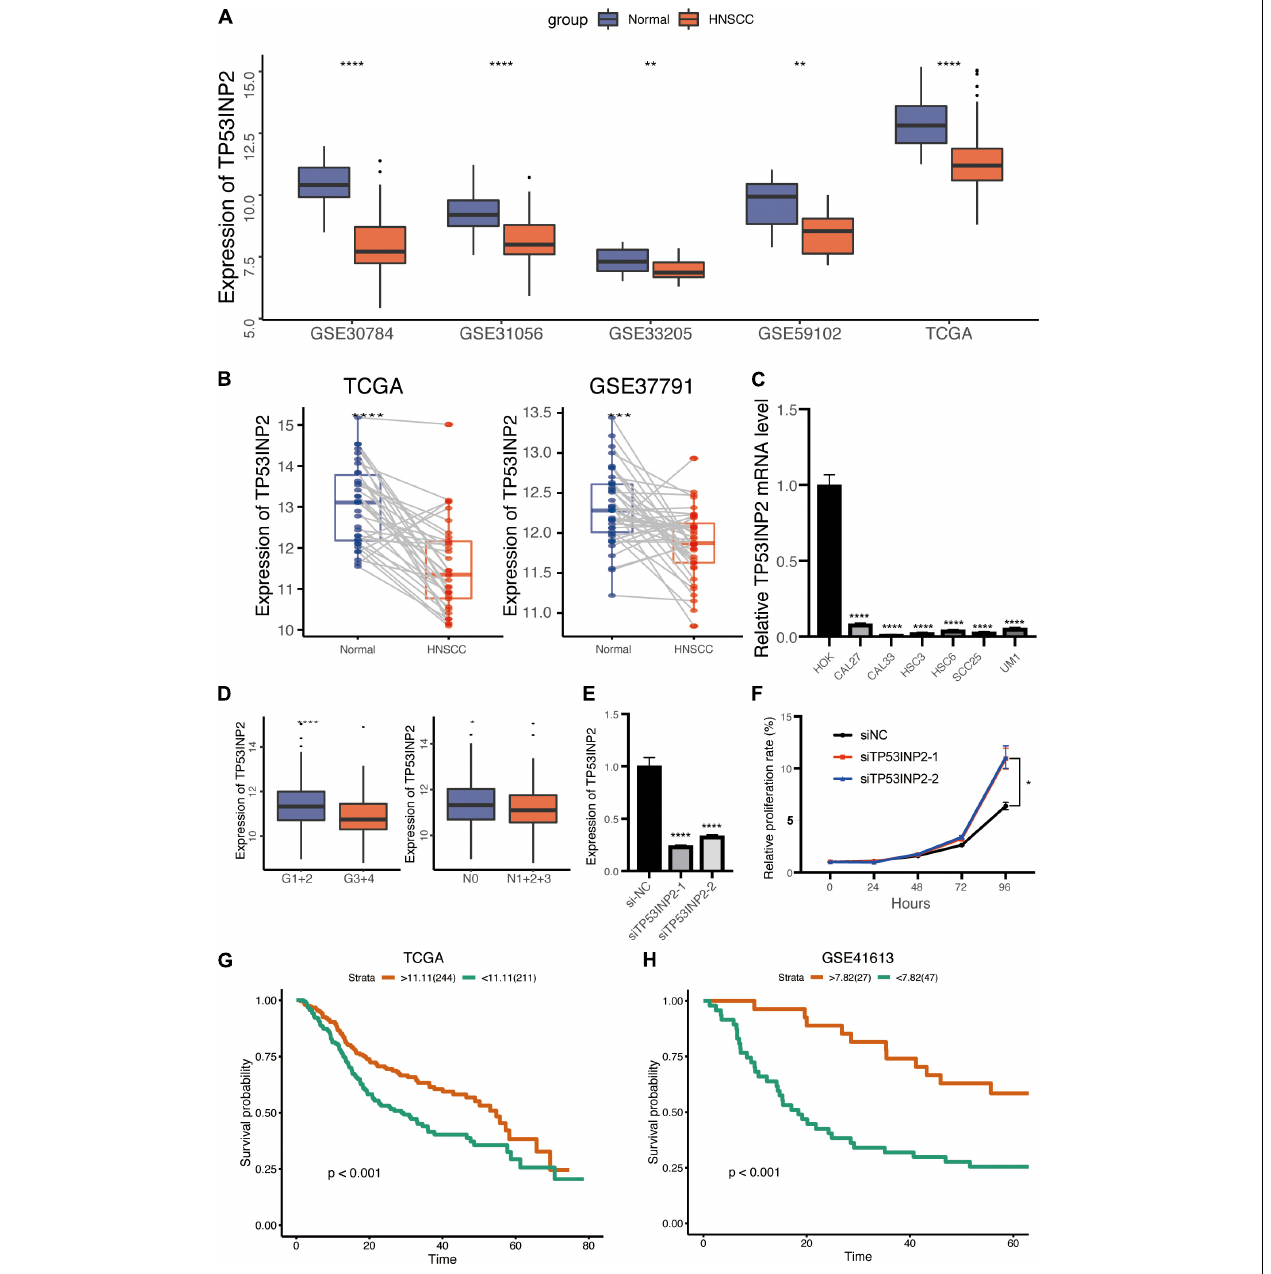
FIGURE 1 | Low expression of TP53INP2 predicts prognosis in HNSCC. (A) Box plot of TP53INP2 expression between HNSCC and normal controls in multiple datasets. (B) Box plot of TP53INP2 expression between HNSCC and paired normal controls. (C) The relative expression of TP53INP2 expression between HNSCC cell lines and normal controls. (D) Box plot of TP53INP2 in grade and lymphatic metastasis subgroup. (E) TP53INP2 mRNA levels in CAL27 cell transfected with TP53INP2 siRNA. (F) Relative cell viability of CAL27 cell was measured by the CCK-8 at indicated time points. (G,H) Survival analysis of TP53INP2 in TCGA and